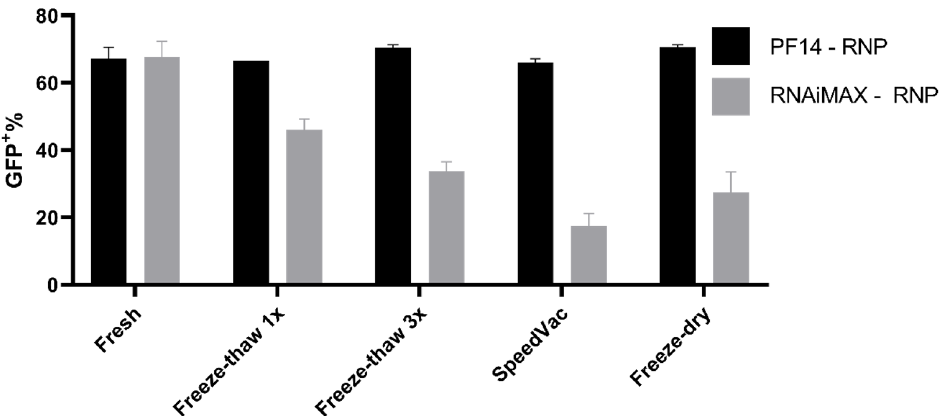
Figure 7. Storage capabilities of PF14-Cas9 RNP complexes. Comparison of 50 ng Cas9 complexed with either PF14 (MR 1:150) or RNAiMAX and subsequent editing efficiency after different storage conditions. The Cas9 RNP-PF14 was formulated in DMEM/PVA-PEG buffer. n =